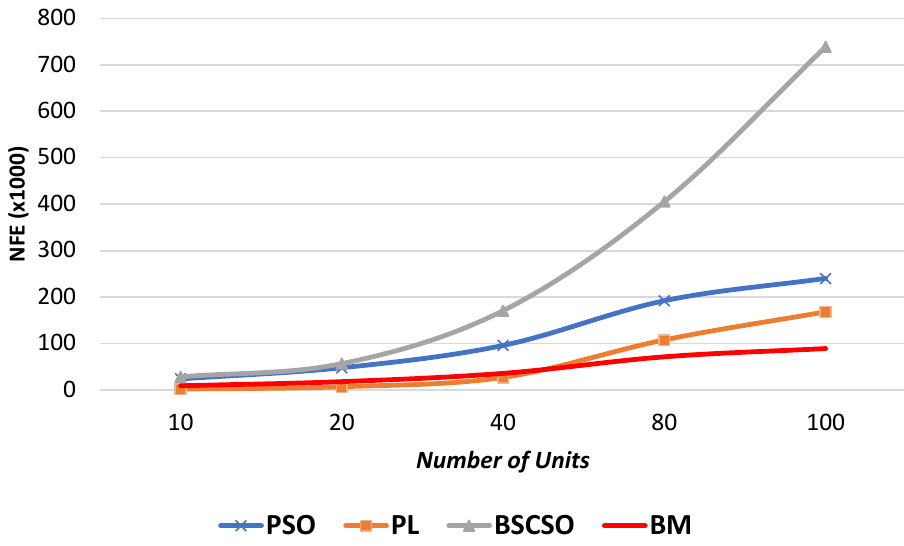
Figure 6. Number of function evaluations pertaining to the potential competitors.